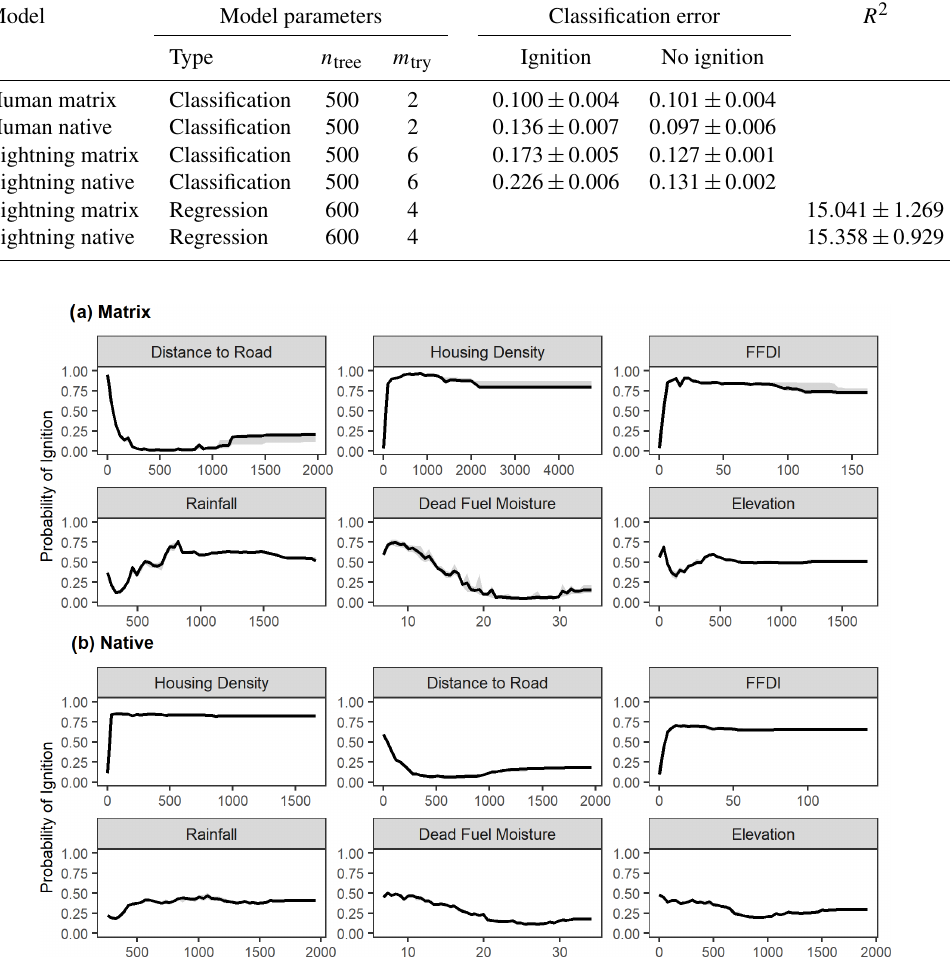
Figure 4. Partial dependence plot for the six top variables in the random forest model for human-caused fire ignitions in (a) matrix and (b) native forest. Variables are plotted in order of importance. Black lines are the average probability of ignition from the 10 models produced during the 10-fold cross-validation. Grey error bars represent the upper and lower estimates from the 10-fold